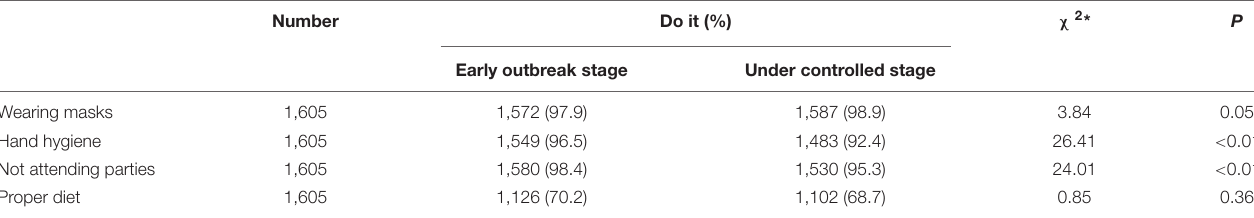
Number χ 2 * P Early outbreak stage Under controlled